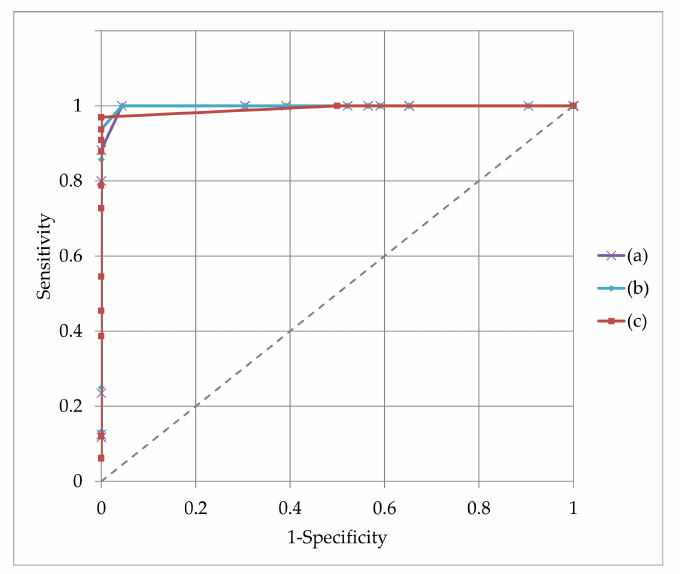
Figure 14. Assessment of the alignment method performance for three values of the evaluation criteria, the mean distance between fragments bones: ( a ) 0.5 mm, ( b ) 0.7 m and ( c ) 1